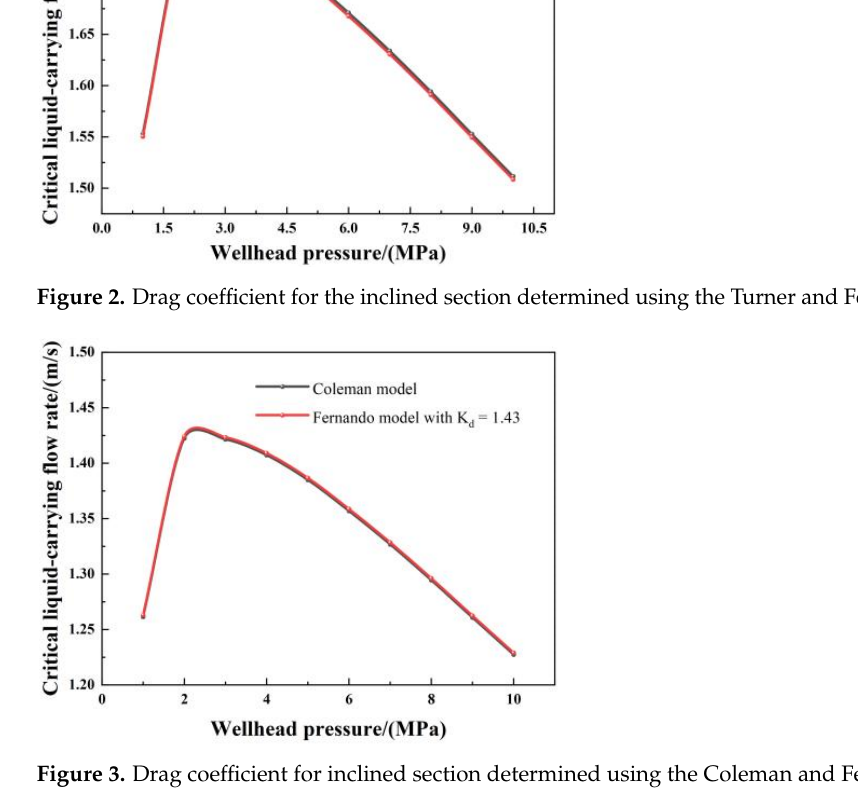
Figure 3. Drag coefficient for inclined section determined using the Coleman and Fernando models.